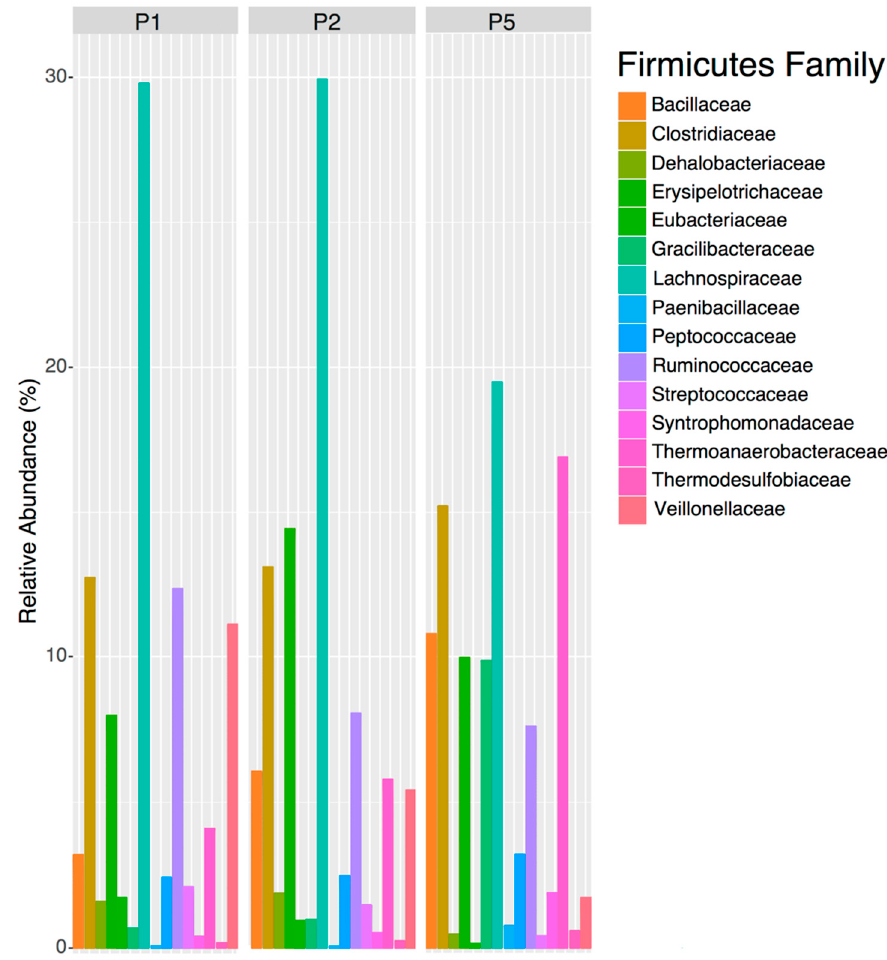
Figure 6. Relative abundance within the Firmicutes of the 15 Firmicute families above 0.1%. Family-level relative abundances are calculated for the Firmicute phyla only, not relative to all of the bacterial taxa measured. The total number of Firmicutes families measured = 39. See Appendix A Figure A3 for the relative abundance of the 39 families and Table A5 for the relative abundance values of the 15 families above 0.1%. P1 = Pond 1, P2 = Pond 2 and P5 = Pond 5.